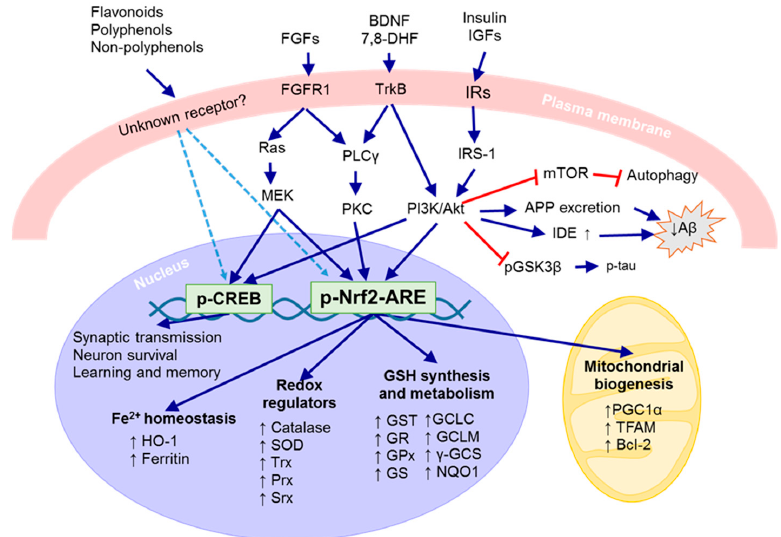
Figure 2. Neuronal defense systems. A group of natural products appear to activate unknown signaling pathways (dotted lines) that lead to the activation of neurotrophic (CREB) and antioxidant (Nrf2-ARE) defense systems in neurons. FGFR1 activated by fibroblast growth factors (FGFs) induces Ras-MEK and PLC γ -PKC signaling pathways that activate CREB and Nrf2. TrkB activated by brain- derived neurotrophic factor (BDNF) and 7,8-DHF induces PLC γ -PKC and PI3K-Akt signaling pathways that activate CREB and maybe Nrf2. Insulin receptors (IRs) activated by insulin or IGFs